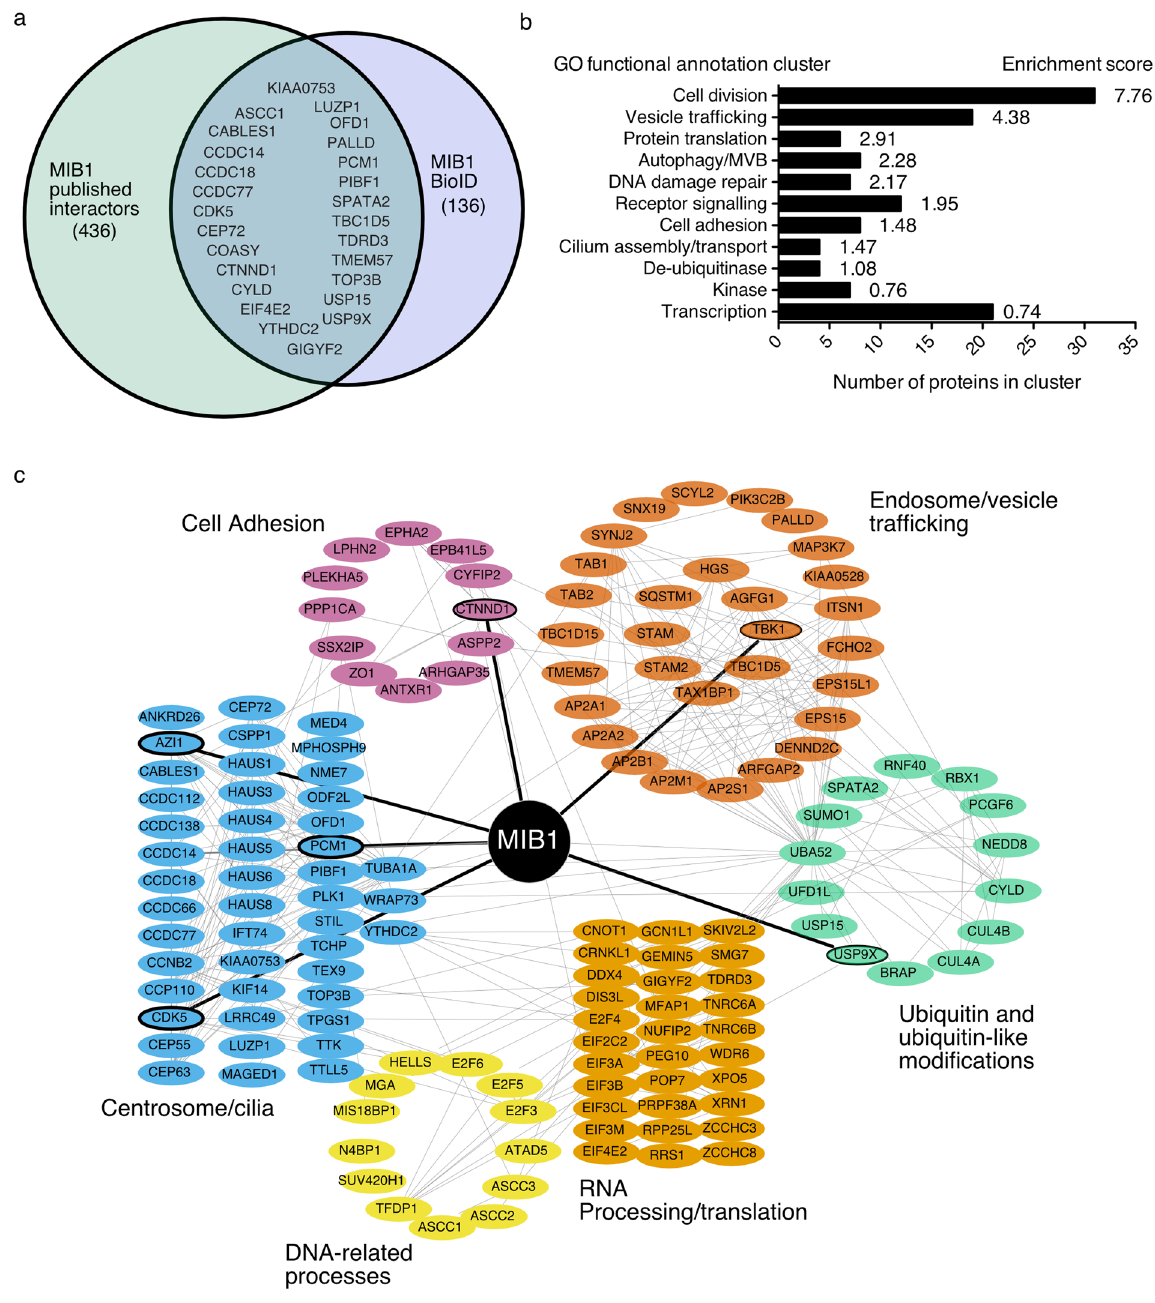
Figure 1. Identification of MIB1 proximity interactome using BioID. ( a ) Venn diagram of the MIB1 BioID protein data set and published MIB1 interactors obtained from BioGRID (https://thebiogrid.org) where MIB1 was bait. ( b ) Graph showing GO functional annotation clusters for the MIB1 BioID dataset. MIB1 proximity interactors were uploaded to the online Database for Annotation, Visualization and Integrated Discovery, DAVID, and clustered using an EASE of 1.0 and medium stringency. ( c ) Schematic representation of 147 of 163 proteins identified using BioID with FlagBirA * -MIB1 expressed in HEK293 cells. SAINT data were uploaded to string-dp.org for network analysis. The resulting network was imported into Cytoscape 3.6.1 for figure preparation. Nodes represent unique proteins identified and categorized according to the indicated function based on information in Entrez Gene, UniProt and primary literature. Light grey edges represent protein-protein interactions determined by STRING (interaction score of 0.4 or greater). Nodes and edges in bold are previously published MIB1 interactors or substrates. The complete list of unique interactors is shown in Table